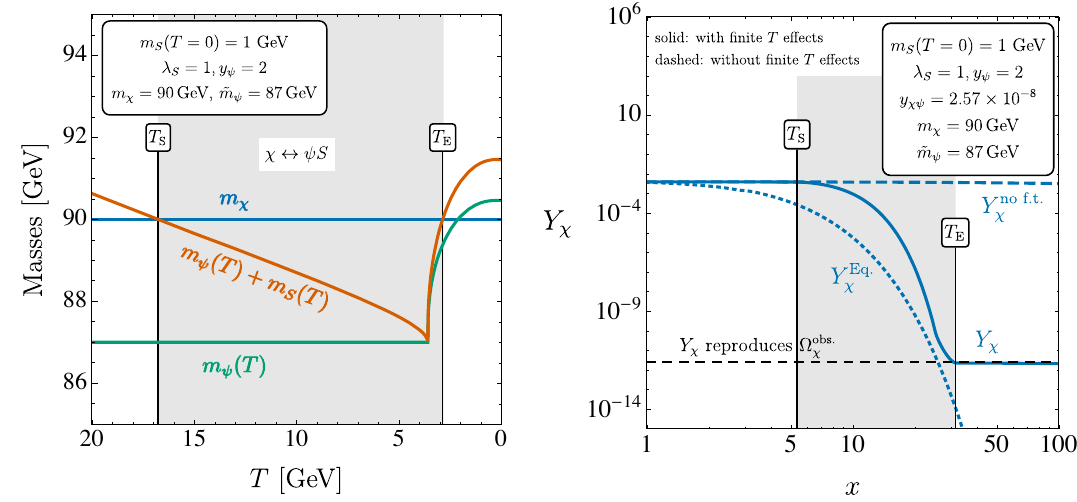
Figure 10 . Left: the masses of (cid:31) and as a function of temperature, along with the period where the channel (cid:31) $ S is kinematically allowed. Right: the evolution of the yield of (cid:31) as a function of temperature (solid) with the equilibrium yield of (cid:31) (dotted) and the yield calculated without accounting for the (cid:12)nite temperature e(cid:11)ects (dashed). Also shown is the yield which is required to obtain the observed relic abundance of (cid:31) (black,